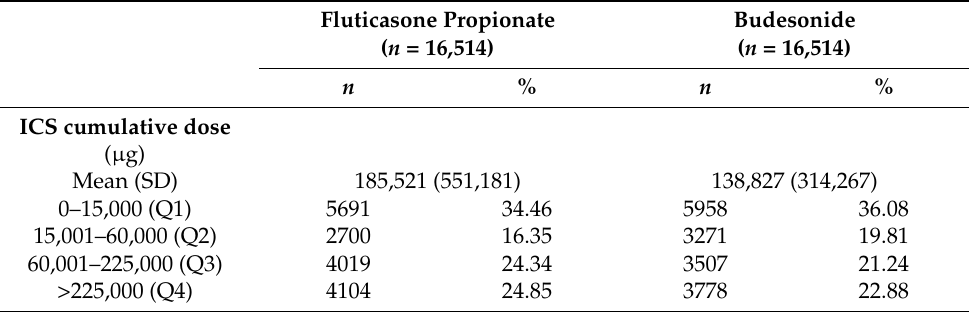
Table 2. Proportion of participants according to the cumulative doses of ICSs.